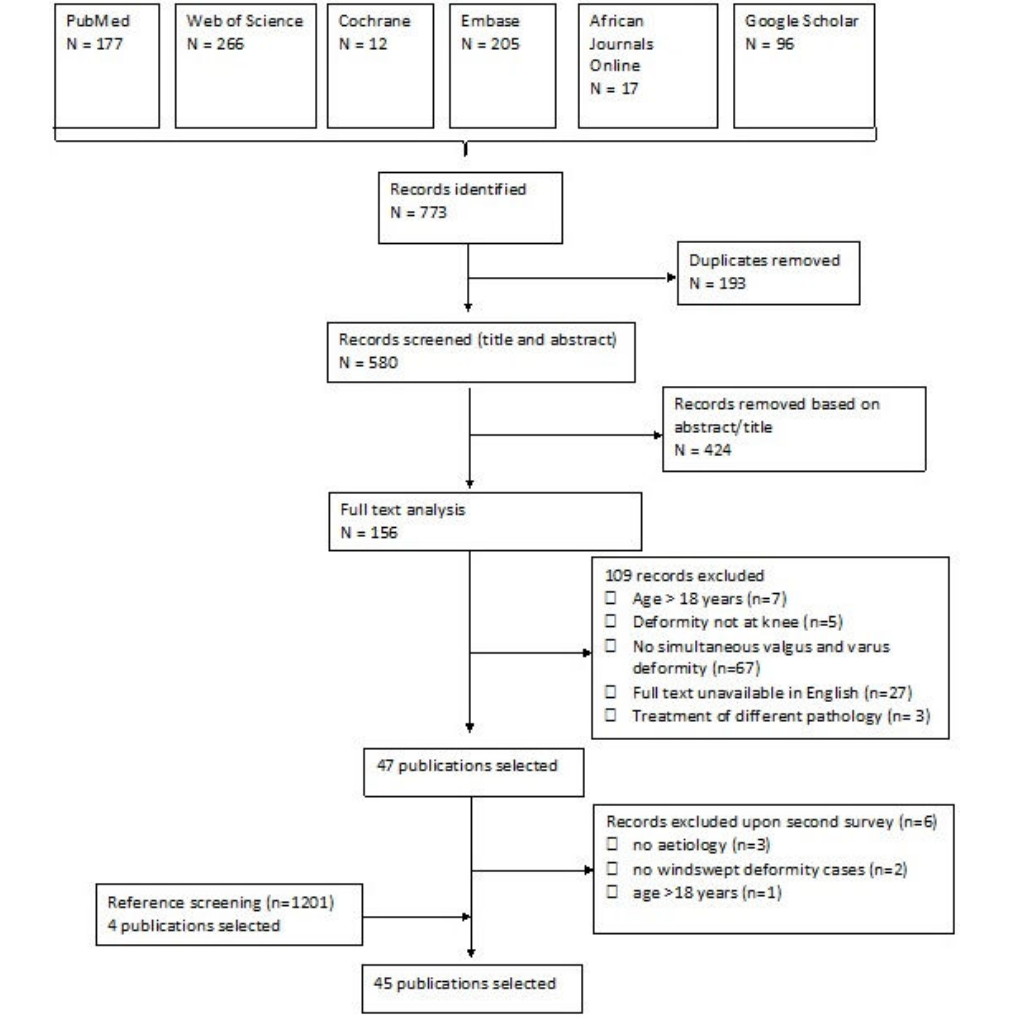
Figure 1. Flow diagram of studies screened and included in the